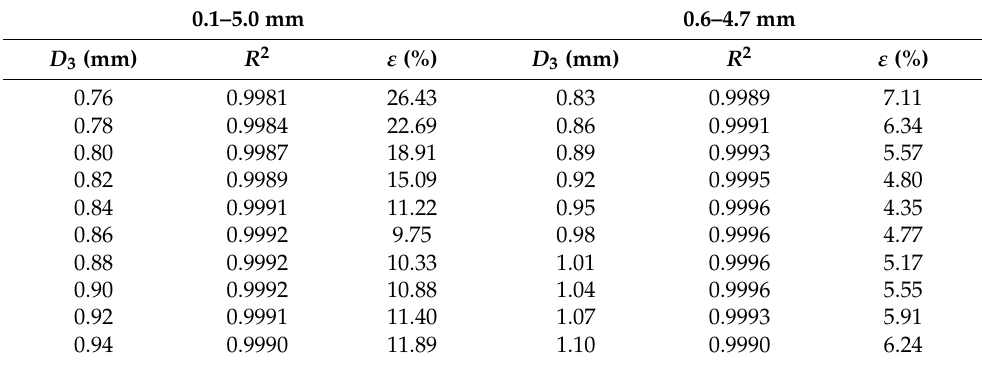
Table 4. Linear regression of the experimental results.